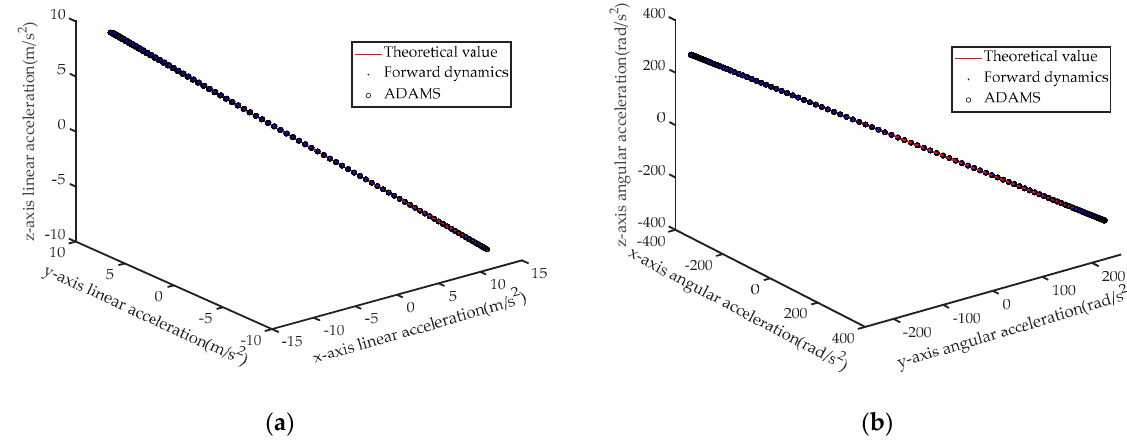
Sensors 2021 , 21 , x FOR PEER REVIEW